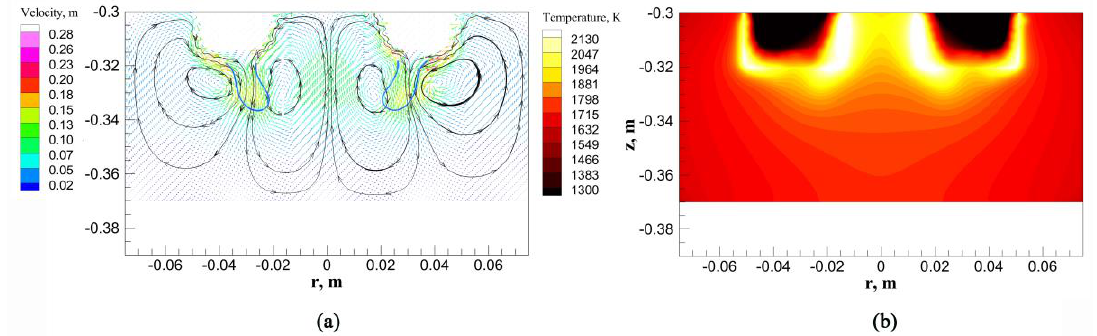
Figure 9. Distribution of velocity field and temperature field of numerical simulation at t d . ( a )velocity field. Blue line represents the outline of droplet. Black ling represents flow stream line. ( b )temperature